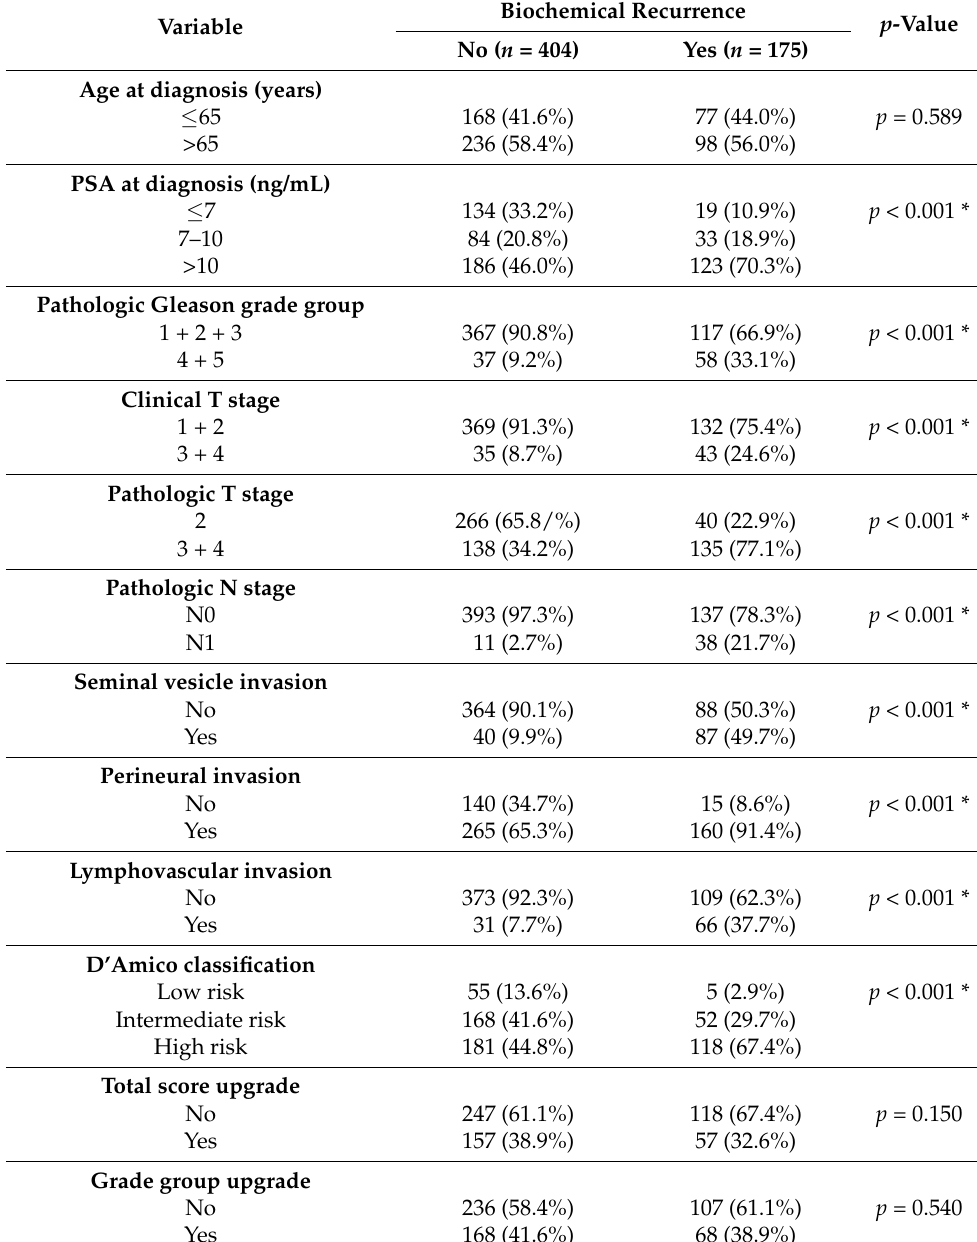
Table 1. The distributions of demographical characteristics in 579 patients with prostate